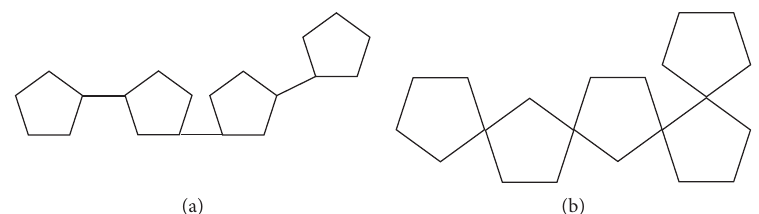
Figure 1: Two types of pentachains considered in this paper: (a) alpha-pentachain; (b) spiro-pentachain.